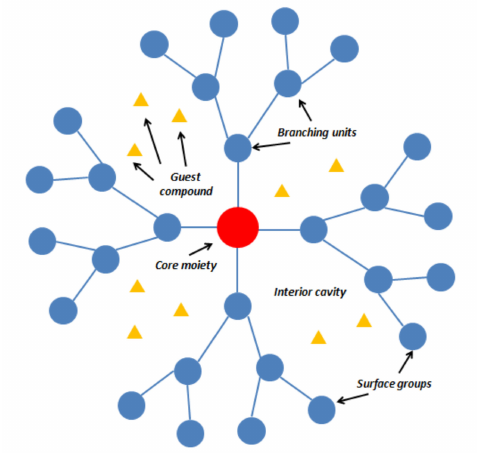
Figure 13. General structure of